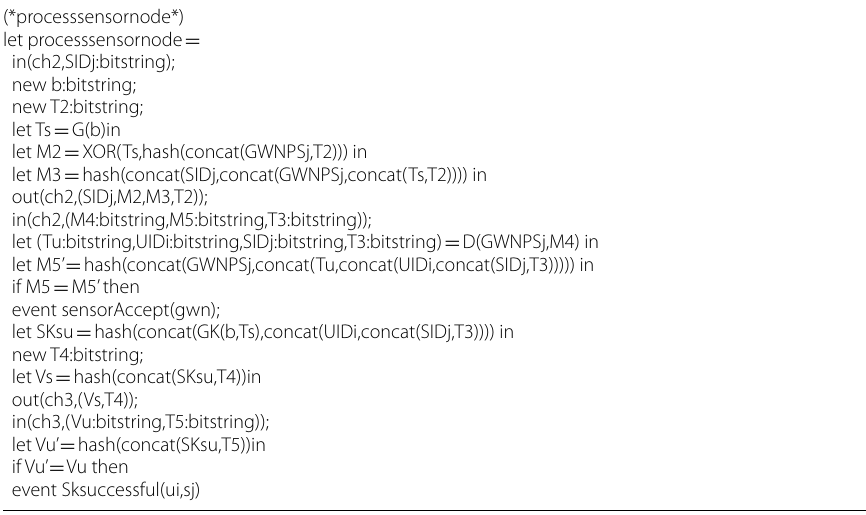
Table 4 Sensor node simulation process